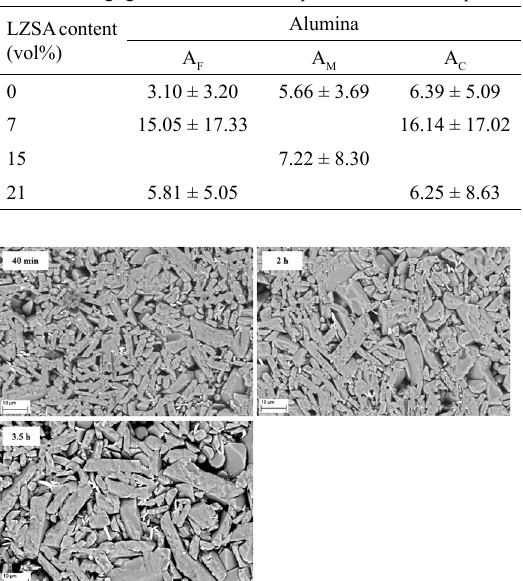
Figure 4. SEM observations of composite A ºC and different holding times (40 min, d and 3.5 h, d = 0.99). rel